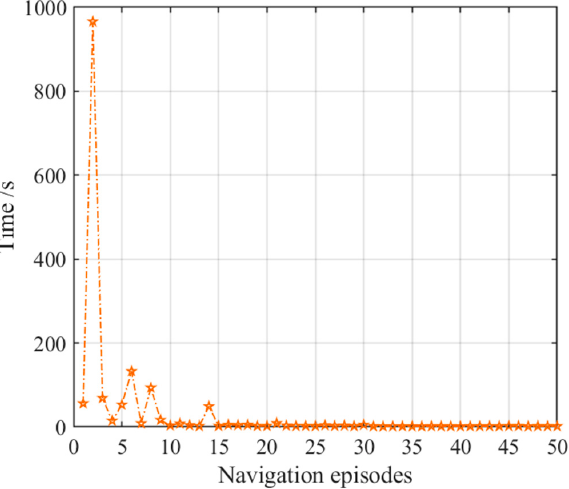
Figure 12. Navigation time with the striatal model alone. Orange pentagrams indicate the navigation time for each navigation episode.